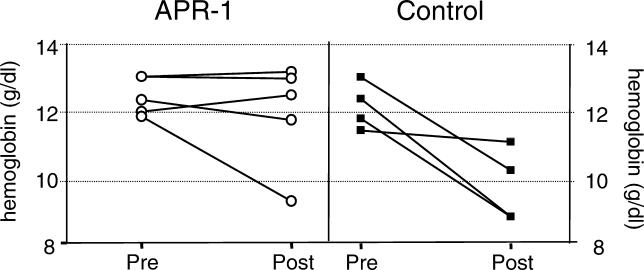
Vaccination of Dogs with APR-1 Reduces Blood Loss and Protects against AnemiaHb concentrations of vaccinated dogs were significantly (p = 0.049) greater than those of control dogs when blood was drawn after larval challenge (0 and 7 d before necropsy [post]) but not when blood was drawn 5 d before larval challenge (pre).